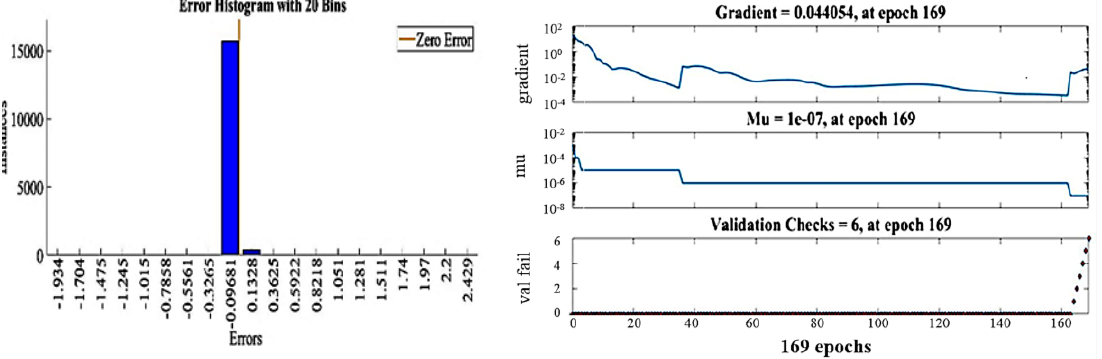
Figure 11. Error histogram of MLP. Figure 12. Training statistics of